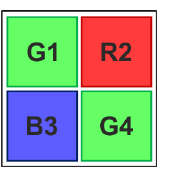
Figure 2. Bayer-pattern block